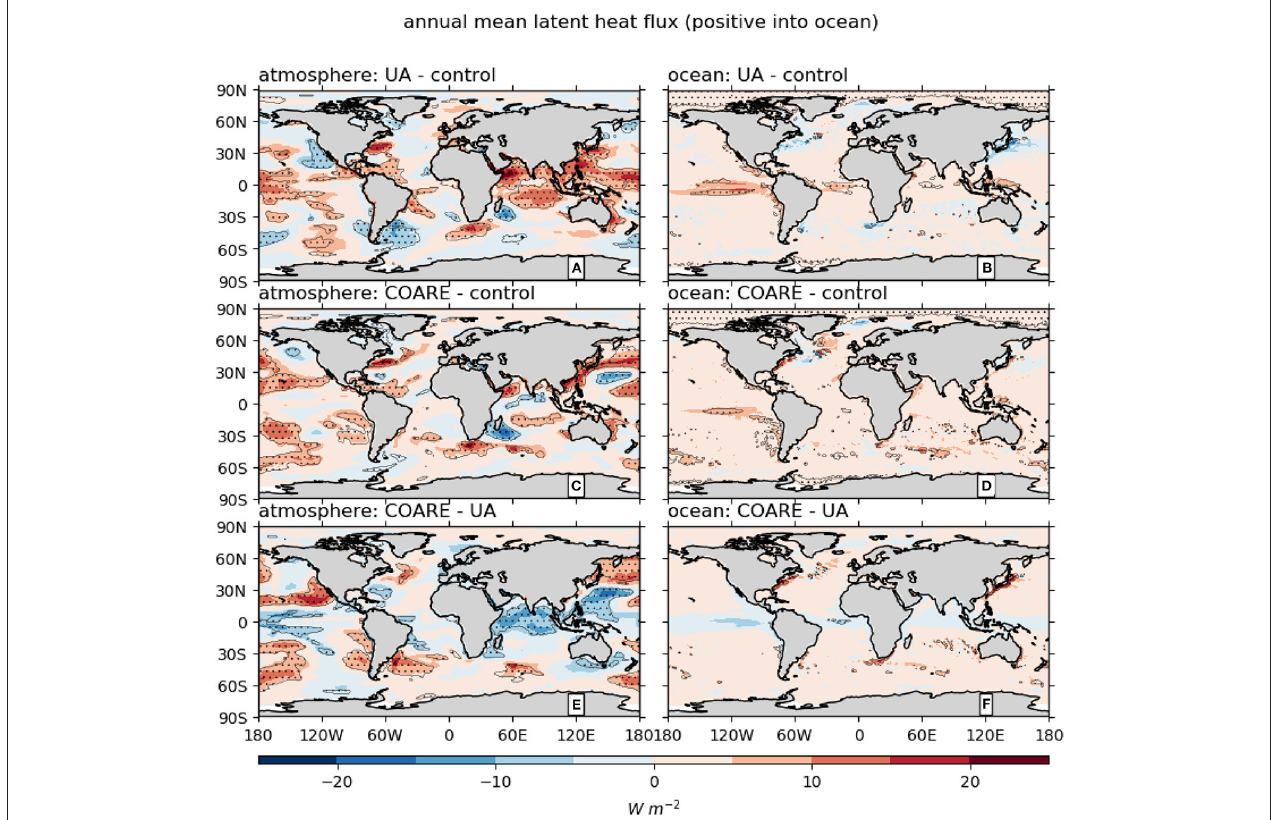
FIGURE 1 | Differences in annual mean latent heat flux climatology between simulations with different bulk flux algorithms. The atmosphere and ocean simulation results are shown in left and right panels, respectively. Stippling designates regions where the absolute value of the difference is larger than the interannual standard deviation from the E3SMv1 pre-industrial control run (shown in Supplementary Figure 2